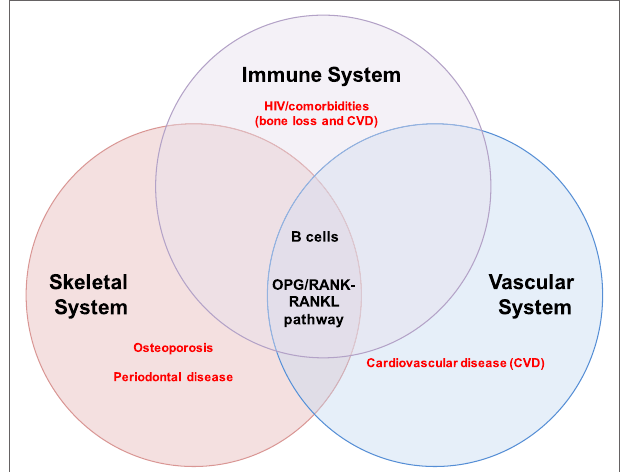
FiGuRe 1 | B cells and the OPG/RANK-RANKL pathway at the intersection of the immune, skeletal, and vascular organ systems. B cells mediate biological processes in health and disease via the OPG/RANK–RANKL pathway in three major organ systems in humans: the immune, skeletal, and vascular systems. The extensive intertwining of the immune and skeletal systems has given rise to a whole new field of study called osteoimmunology; some major pathologies implicating B cells and the OPG/RANK–RANKL pathway are highlighted in red and include osteoporosis and periodontal disease in the skeletal system, cardiovascular disease (CVD) in the vascular system, and HIV/comorbidities (bone loss and CVD) in the immune system.